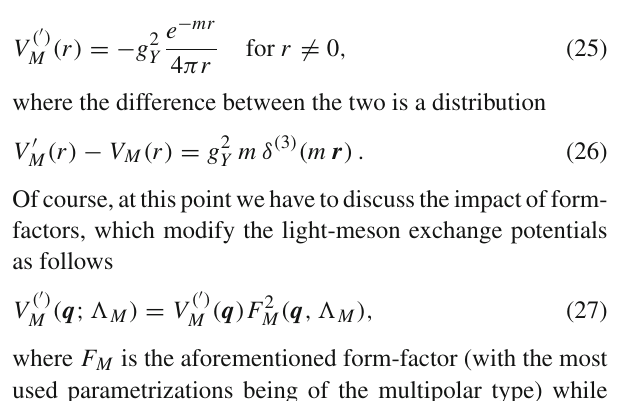
Fig. 1 Masses and hyperfine splitting of the J = 1 P cs pentaquarks.For J = 1 ics ¯ D (cid:3) (cid:3) c - ¯ D ∗ (cid:3) c ( ¯ D ∗ (cid:3) c - ¯ D (cid:3) ∗ c ), which are expected to be LO effects